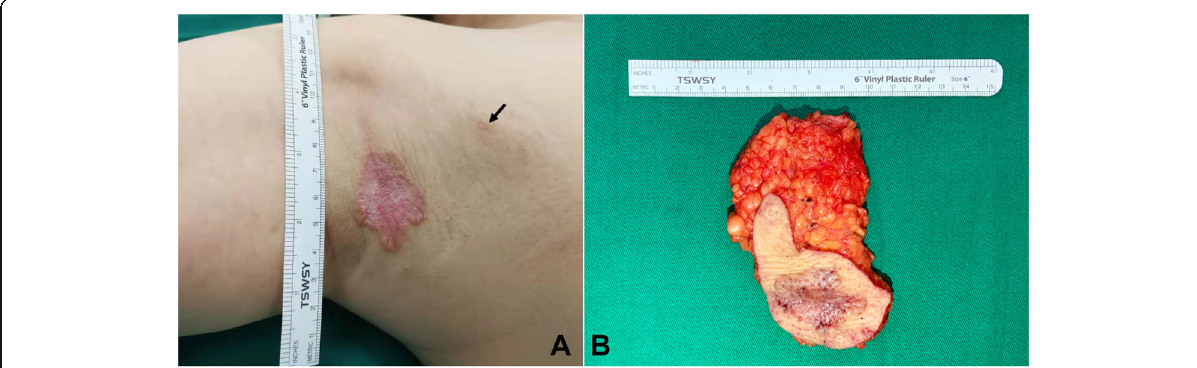
Fig. 1 Axillary skin lesions and wide local excision sample. A The main lesion in the right axilla measured 4 cm × 3 cm and consisted of a well- demarcated erythematous plaque. Another hypopigmented erythematous plaque, measuring 0.5 cm × 0.3 cm, was located 3.5 cm away from the lesion (black arrow). B Wide local excision of the main lesion and the satellite lesion (black arrow) with a margin of 0.5 cm to 1 cm and the accessory breast